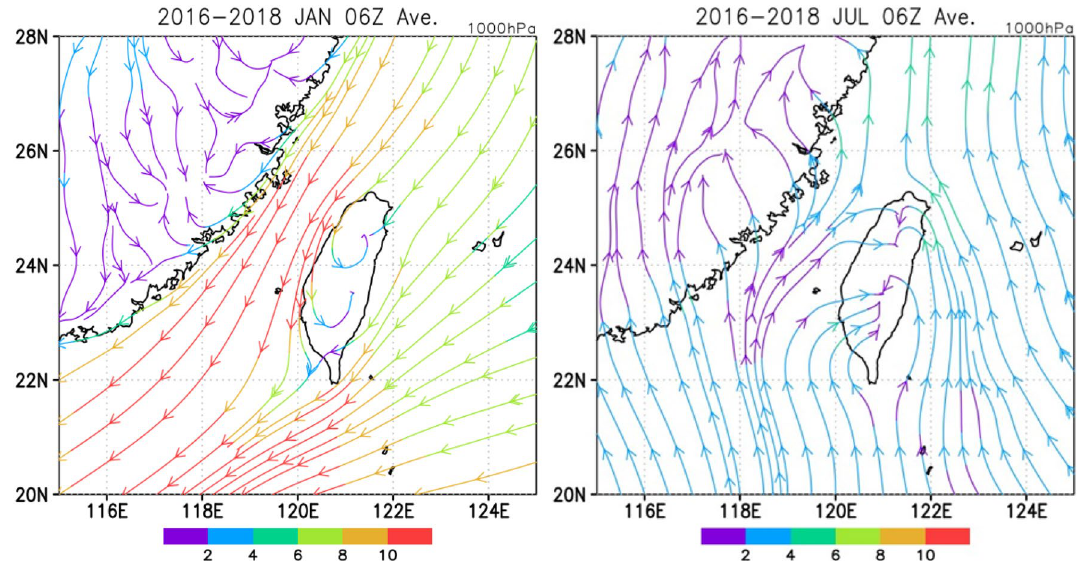
Figure 4. Mean surface streamlines in winter (January) and summer (July) from 2016–2018. The northeasterly East Asian winter monsoon branches reveal geographic blocking over Taiwan Island, which allows the development of side flows moving toward southeastern Taiwan. Weak southerly flows prevail during the summertime, and sea breezes dominate the transport of local air pollutants. The meteorological data at 06 UTC are used to demonstrate the general pattern of the wind field. The data are retrieved from the Global Data Assimilation System